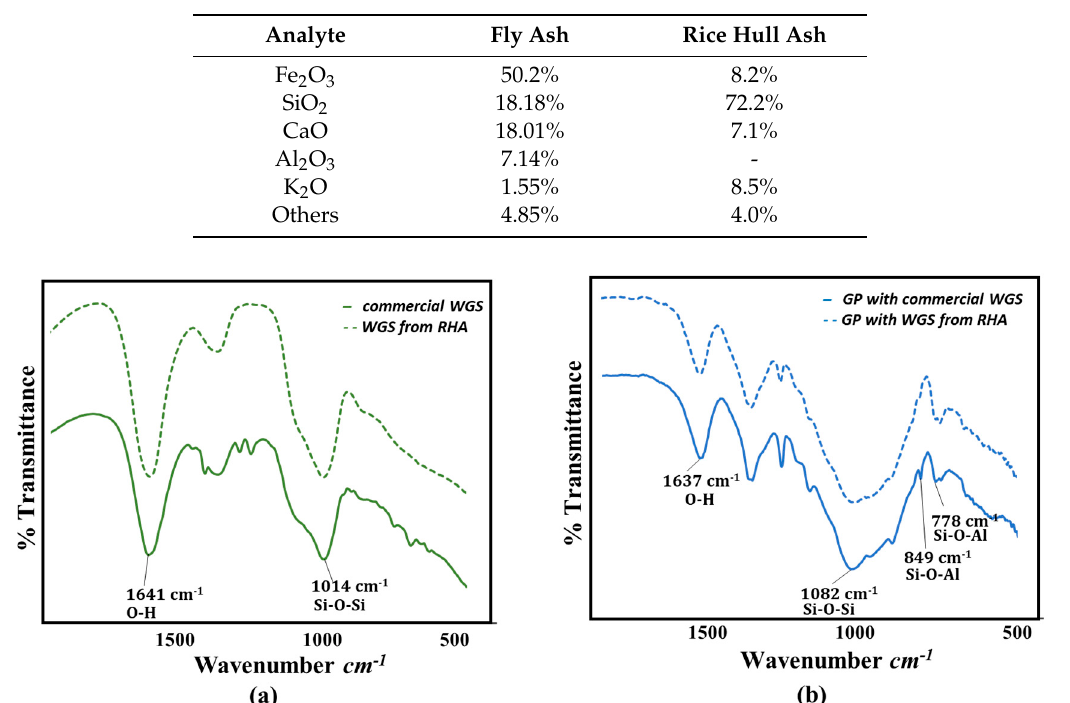
Table 1. Chemical composition from X-ray fluorescence (XRF) of fly ash (FA) and rice hull ash (RHA). Analyte Fly Ash